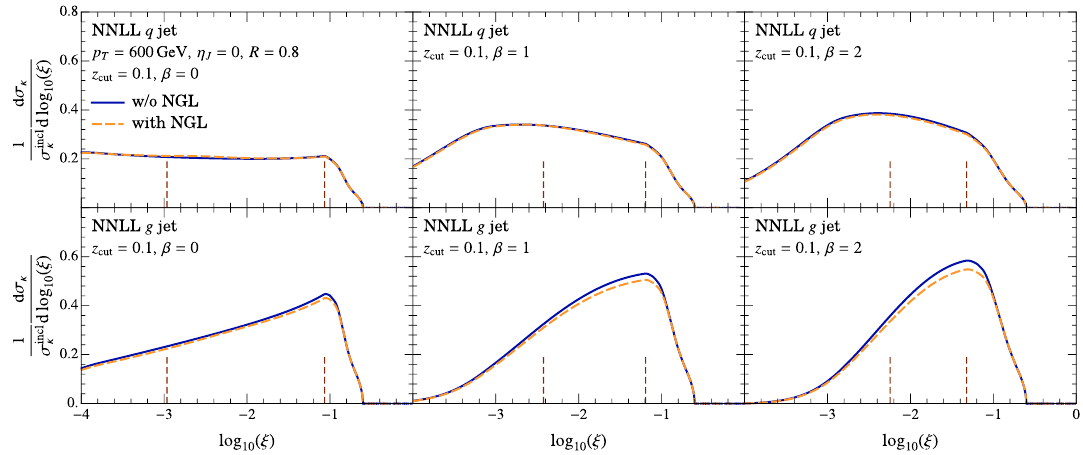
Figure 3 . Impact of non-global logarithms on the matched groomed jet-mass spectrum. Here we treat NGLs at LL and large N limit. The differences between the solid and dashed curves are c within NNLL perturbative